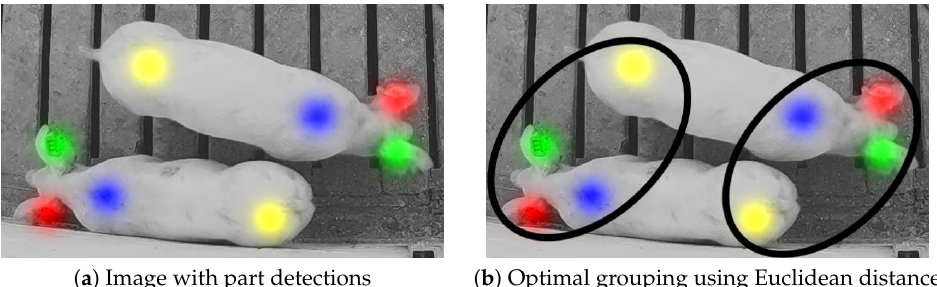
Figure 2. Two nearby pigs with body parts properly annotated are depicted in ( a ). Whole instances must be formed by joining the parts together through part association. An optimal Euclidean nearest-neighbor part association is prone to failure when the animals are in close proximity, as illustrated in ( b